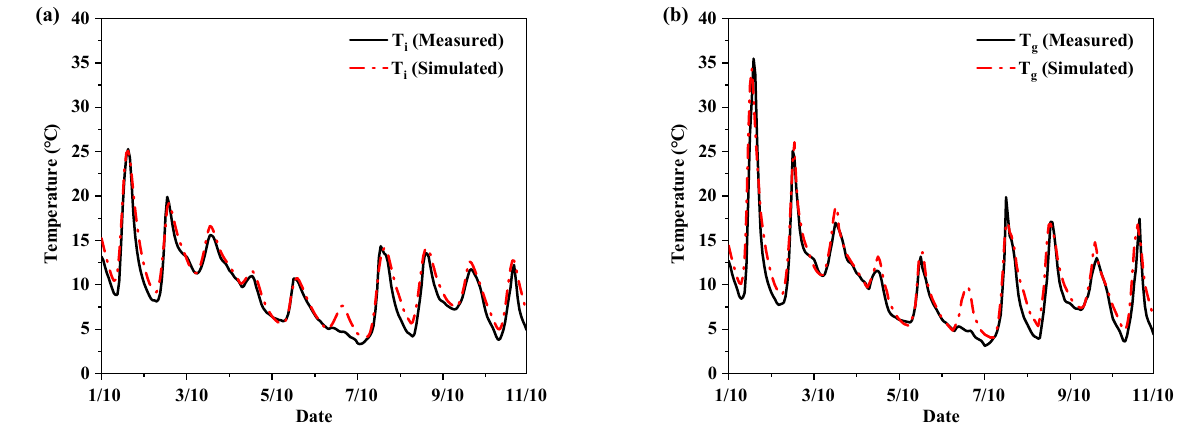
Figure 6. Comparisons between the measured and simulated ( a ) indoor air temperatures; ( b ) internal surface temperatures of glass door.